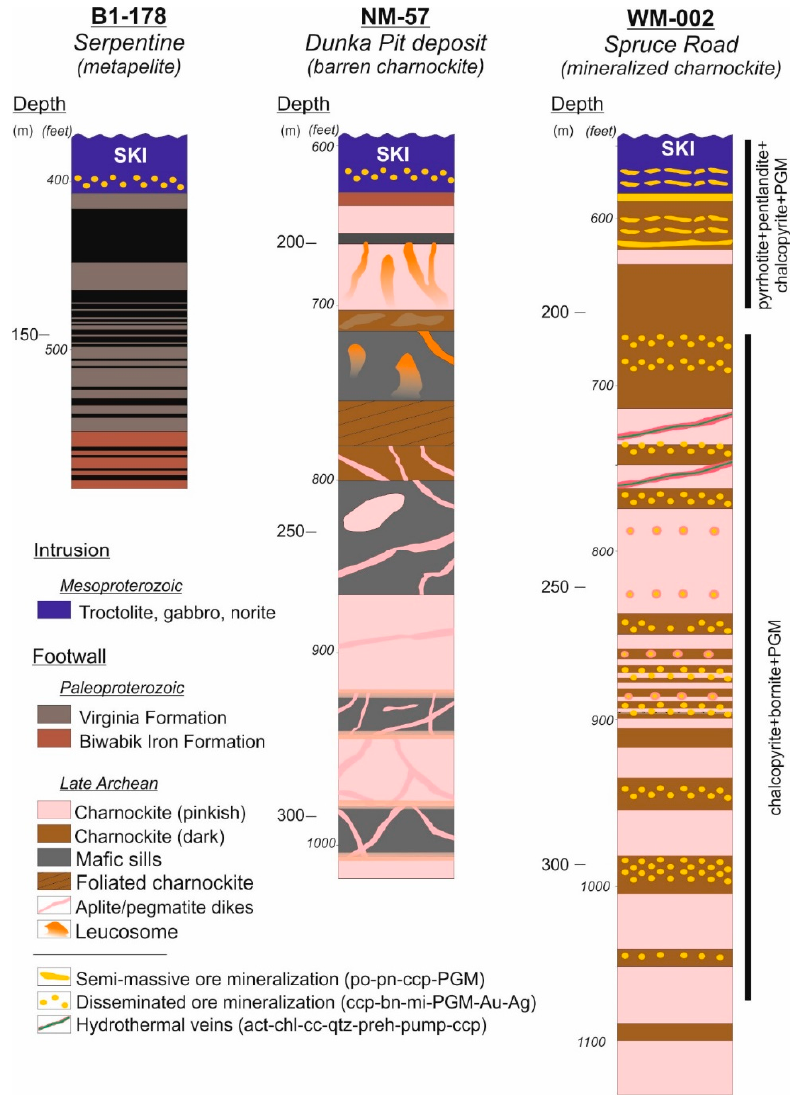
Figure 2. Graphic logs of the footwall part of the sampled drill cores at the Serpentine, Dunka Pit and